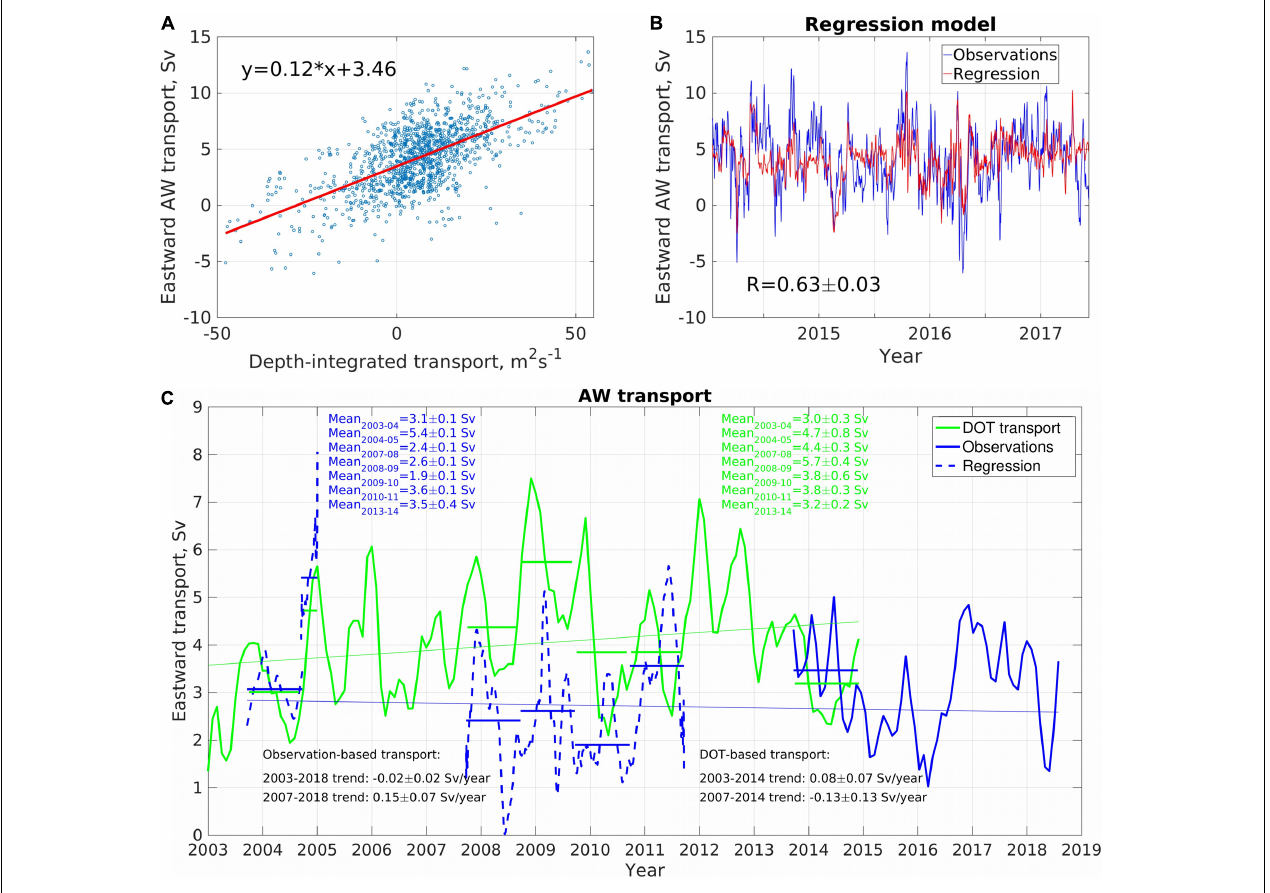
FIGURE 5 | (A) A linear fit between daily depth-integrated transport at mooring M1 4 and the AW volume transport across the Laptev Sea slope in 2013–2018. (B) Daily time series of the observed (blue line) and the restored (red line) AW transports calculated by the linear regression model. R indicates a correlation coefficient. (C) Time series of net barotropic AW volume transport through the central Laptev Sea section estimated from AW volume transport from velocity measurements (blue), and restored using linear regression at M1 4 mooring (blue dashed line) and from DOT data set (green line). Horizontal blue and green